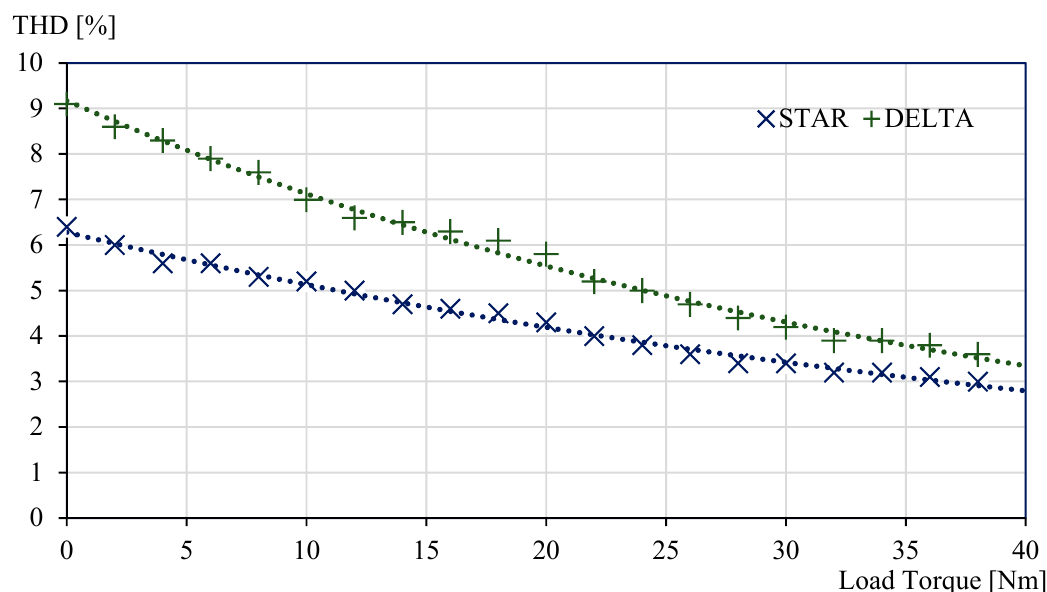
Figure 11. Line current THD for a star and delta; reference speed 500 RPM, reference stator flux 1.7 Wb.